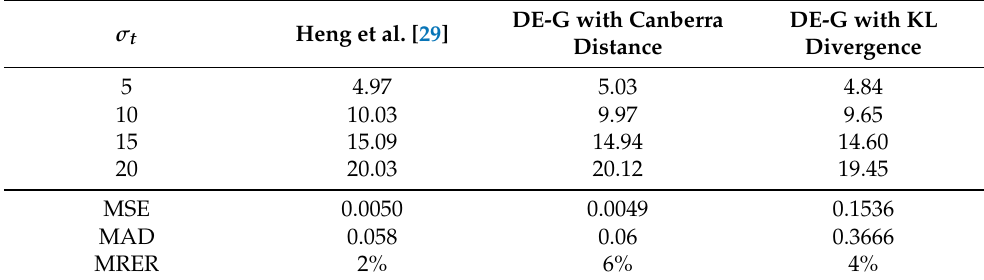
Table 2. Gaussian noise standard deviation estimation. The mean is set to zero, and the strength of the Gaussian noise is determined by the standard deviation.